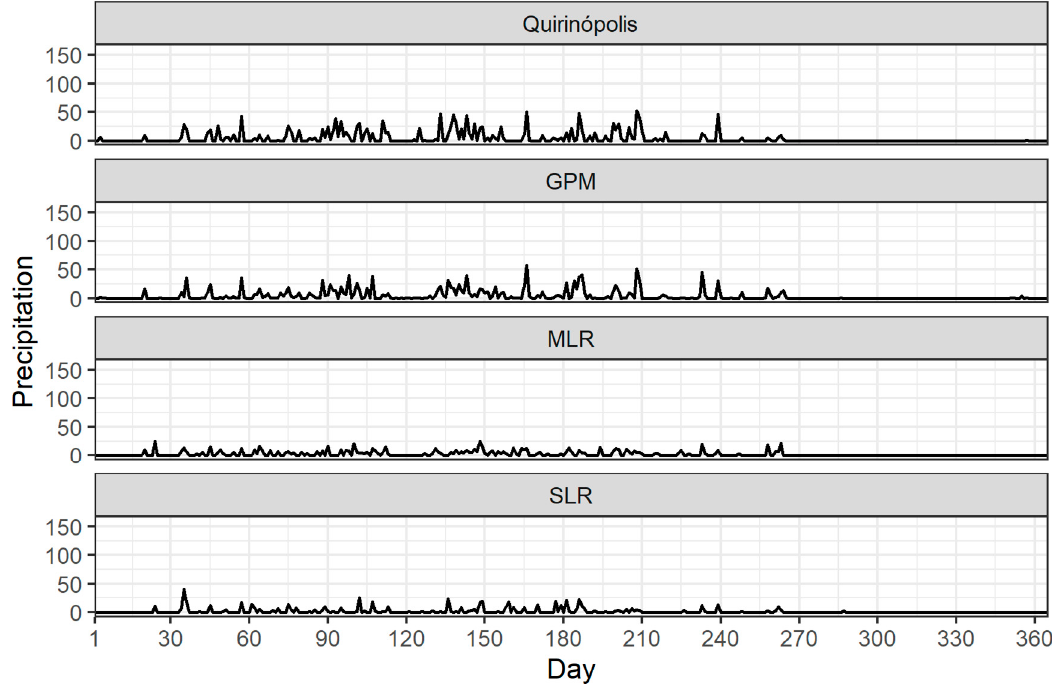
Figure 9. Direct comparisons between daily precipitation estimates and observed data for the period from 1 September 2016 to 31 August 2016 at the Quirinópolis station. OBS, observed data; MLR, multiple linear regression method; SLR, simple linear regression; GPM, Global Precipitation Measurement method.